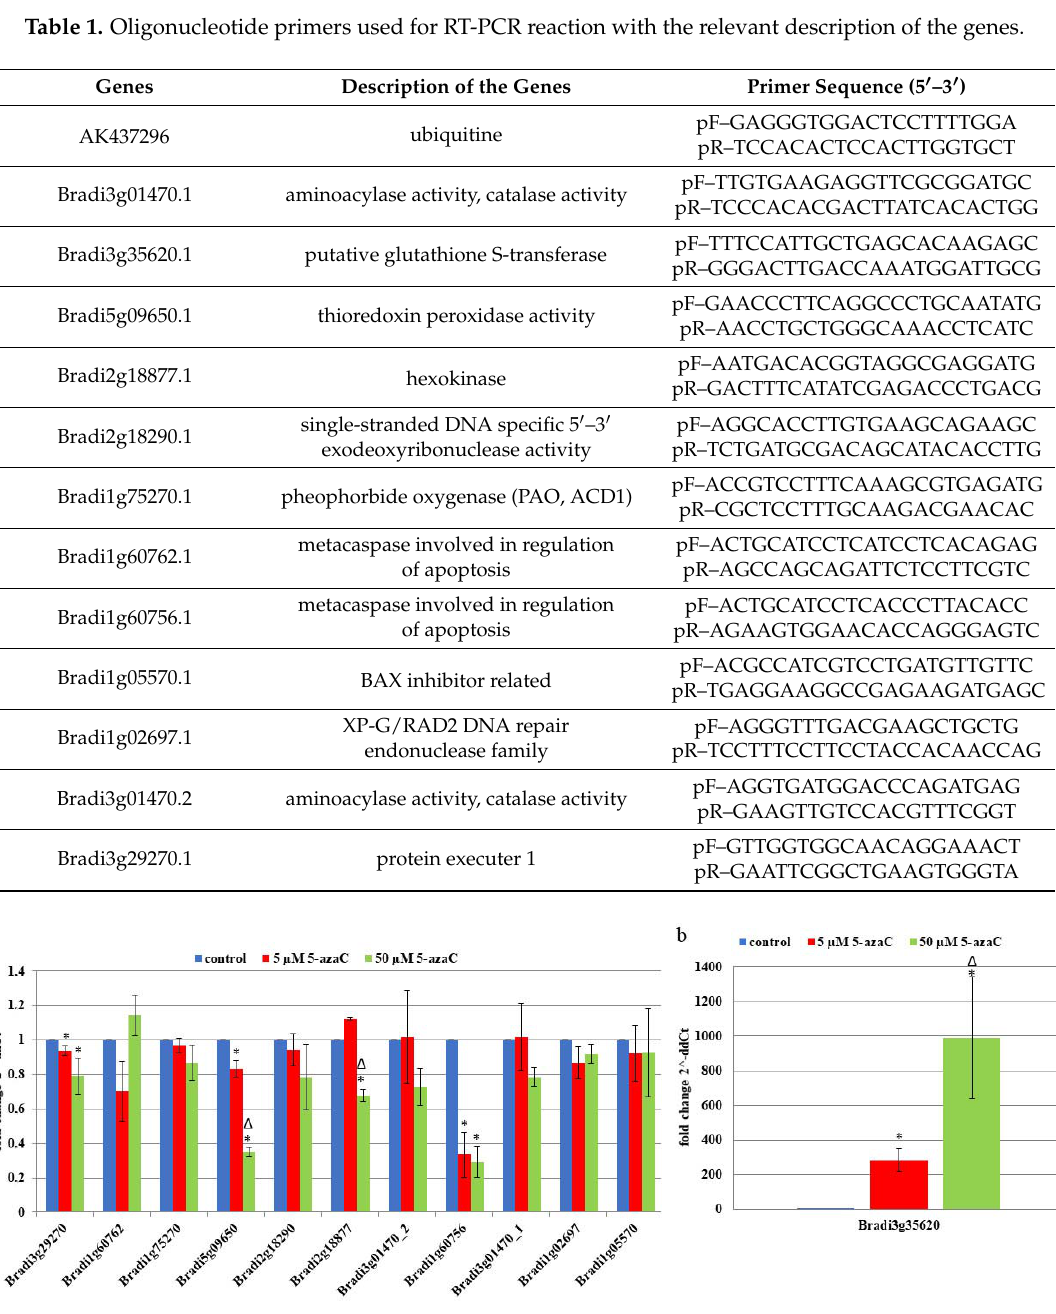
Figure 4. Relative expression levels of the selected PCD-related genes ( a ), in the explants that were cultivated on the CIM medium supplemented with 5 and 50 µ M of 5-azaC ( b ). Relative expression levels were normalized to an internal control (AK437296, gene encoding for ubiquitin) and calibrated to the control culture (CIM medium with no 5-azaC). *: value is significantly different from the control culture ( p < 0.05; n = 3 ± SD), ∆ : value is significantly different from the 5 µ M of 5-azaC-treated culture ( p < 0.05; n = 3 ±